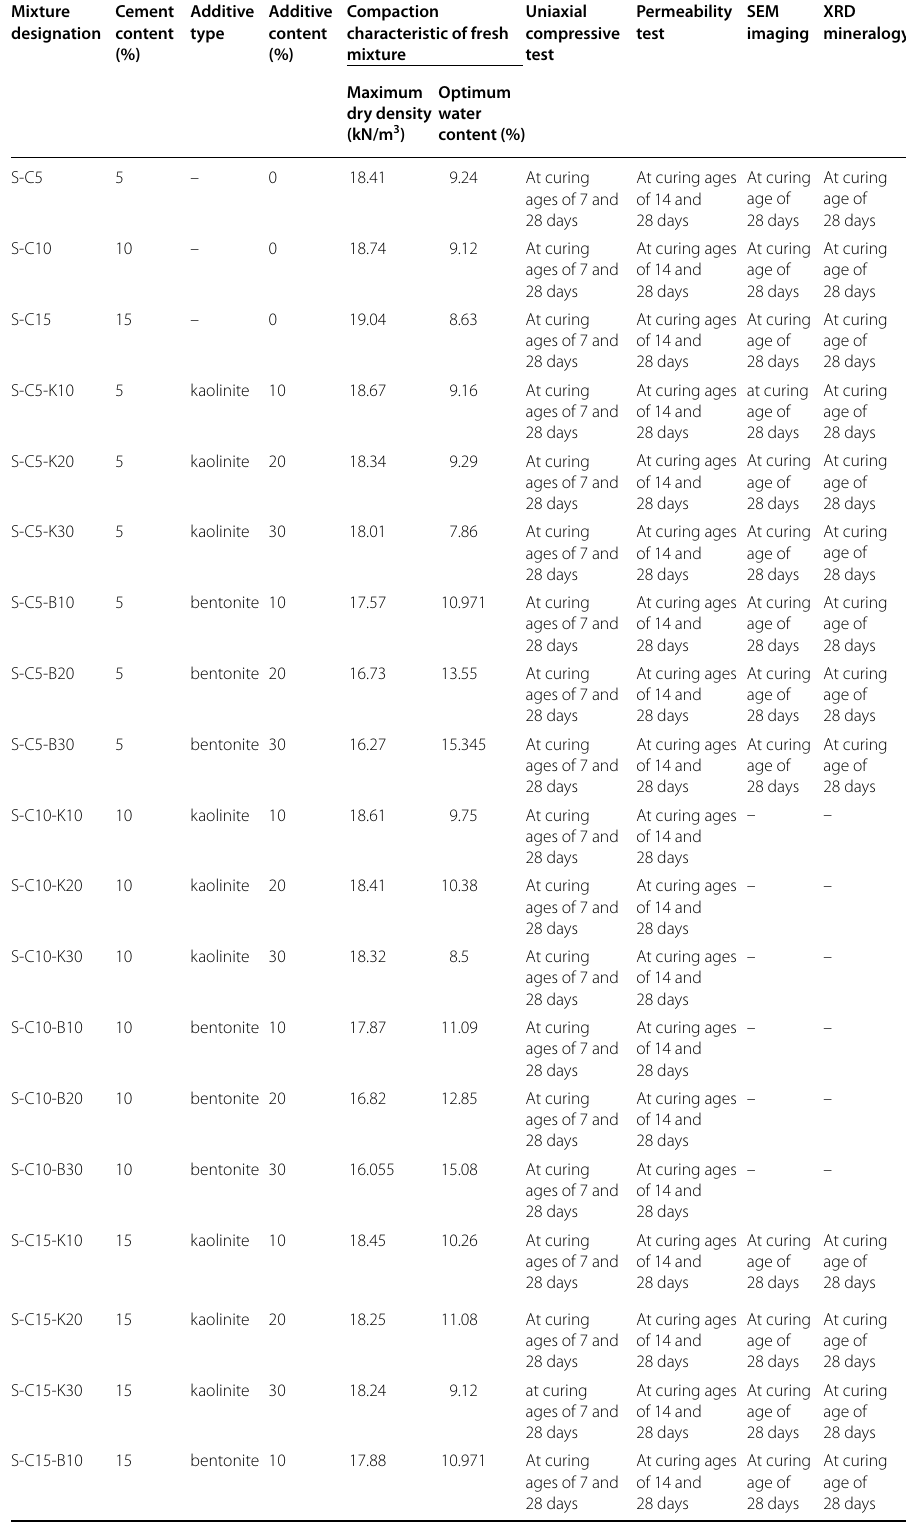
Table 3 The designation of mixture and testing program Mixture Cement designation